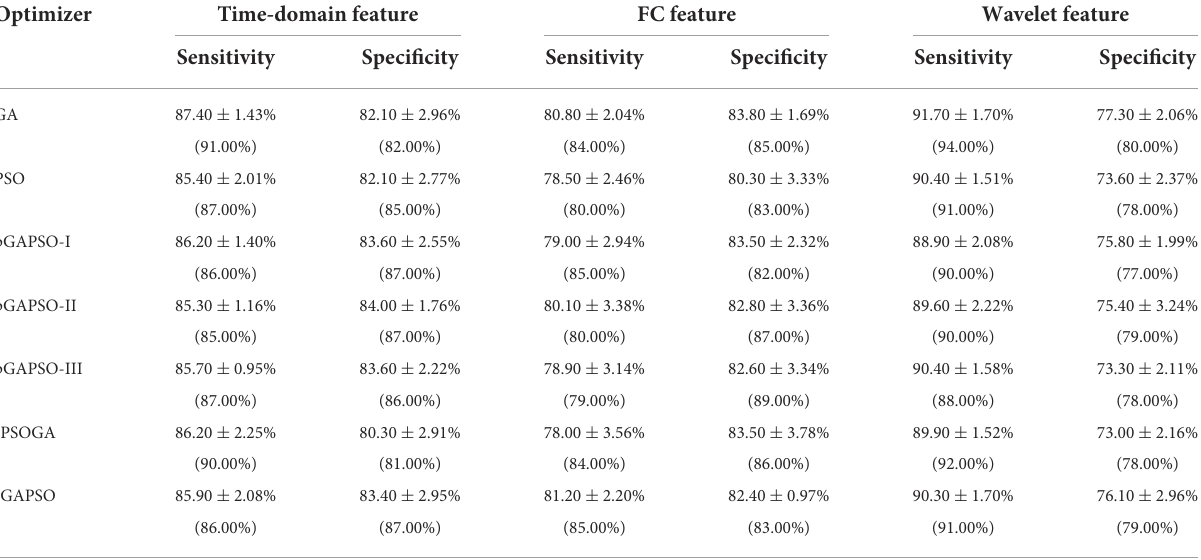
TABLE 3 Sensitivity and specificity of different features and optimizers by 10-fold cross-validation.